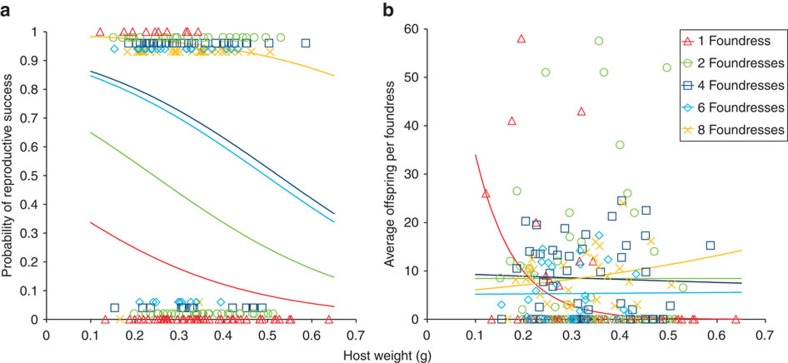
Mutualism in host exploitation.(a) The probability of adult offspring being produced declines as host size increases and is additively higher for larger foundress groups (logistic ANCOVA: host weight, G1=6.38, P=0.012, foundresses, G4=17.06, P<0.001, interaction, G1=1.75, P=0.137, n=220). The fitted regression lines are: probability of reproductive success=1/(1+(1/(exp (−4.32 × host weight−constant)))) with the constants for 1, 2, 4, 6 and 8 foundresses as 0.246, 1.048, 2.267, 2.139 and 4.52, respectively. (b) A larger foundress group size also favours individual foundresses, in terms of mean offspring produced, provided that the host is large; when a host is medium sized, a foundress is likely to produce the most offspring when exploiting it with a smaller group of cofoundresses, or, if the host is small, alone (log-linear ANCOVA: host weight, G1=3.23, P=0.074; foundresses, G4=3.00, P=0.019, interaction: G4=4.80, P<0.001, n=220). The fitted regression lines show the mean offspring production per foundress for each number of foundresses: 1 foundress=exp (−12.4 × host weight+4.764), 2 foundresses=exp (host weight+2.132), 4 foundresses=exp (−0.39 × host weight+2.265), 6 foundresses=exp (0.13 × host weight+1.634), 8 foundresses=exp (1.54 × host weight+1.654). In both panels, sample sizes for 1, 2, 4, 6 and 8 foundresses were 60, 55, 45, 30 and 30, respectively.